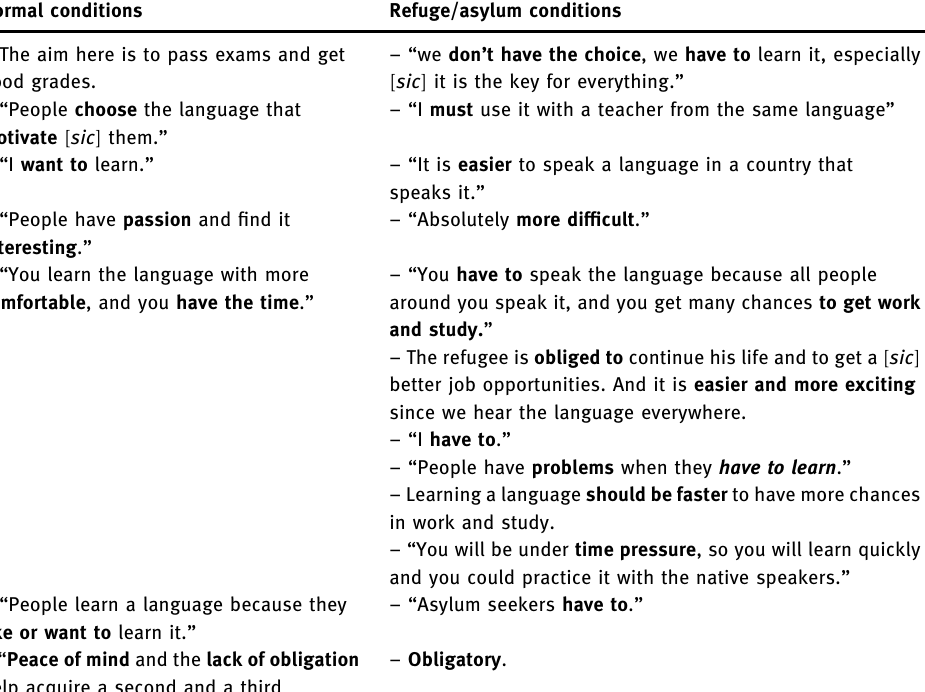
Table 3: SLA in normal vs refuge/asylum conditions Host country Normal